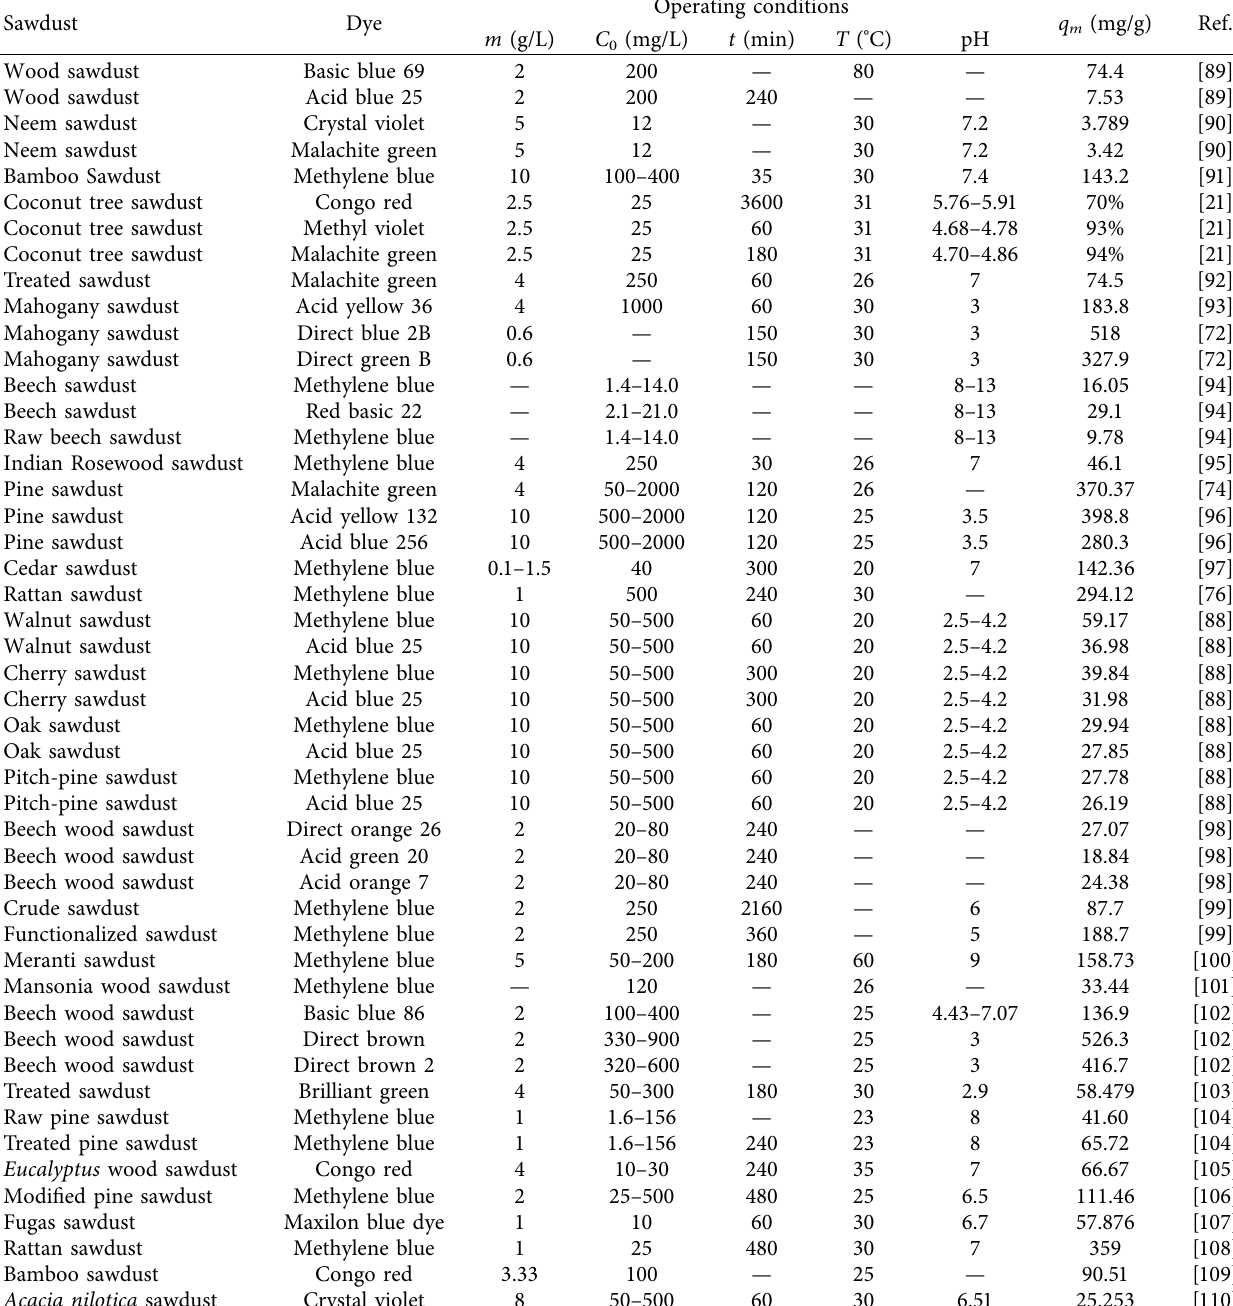
Table 6: Adsorption capacities of activated carbons prepared from various sawdust for various dyes.